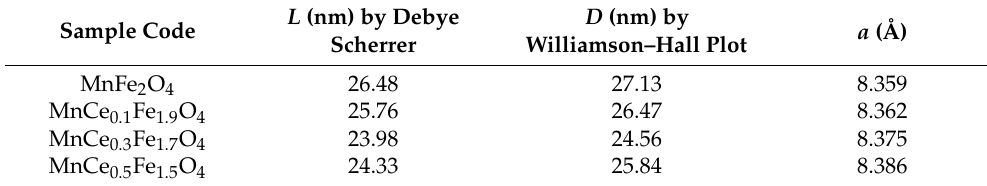
Table 1. The lattice parameter (a, Å) and crystallite size (L, nm) of spinel MnCe x Fe 2 − x O 4 (x = 0.0, 0.1, 0.3 and 0.5)